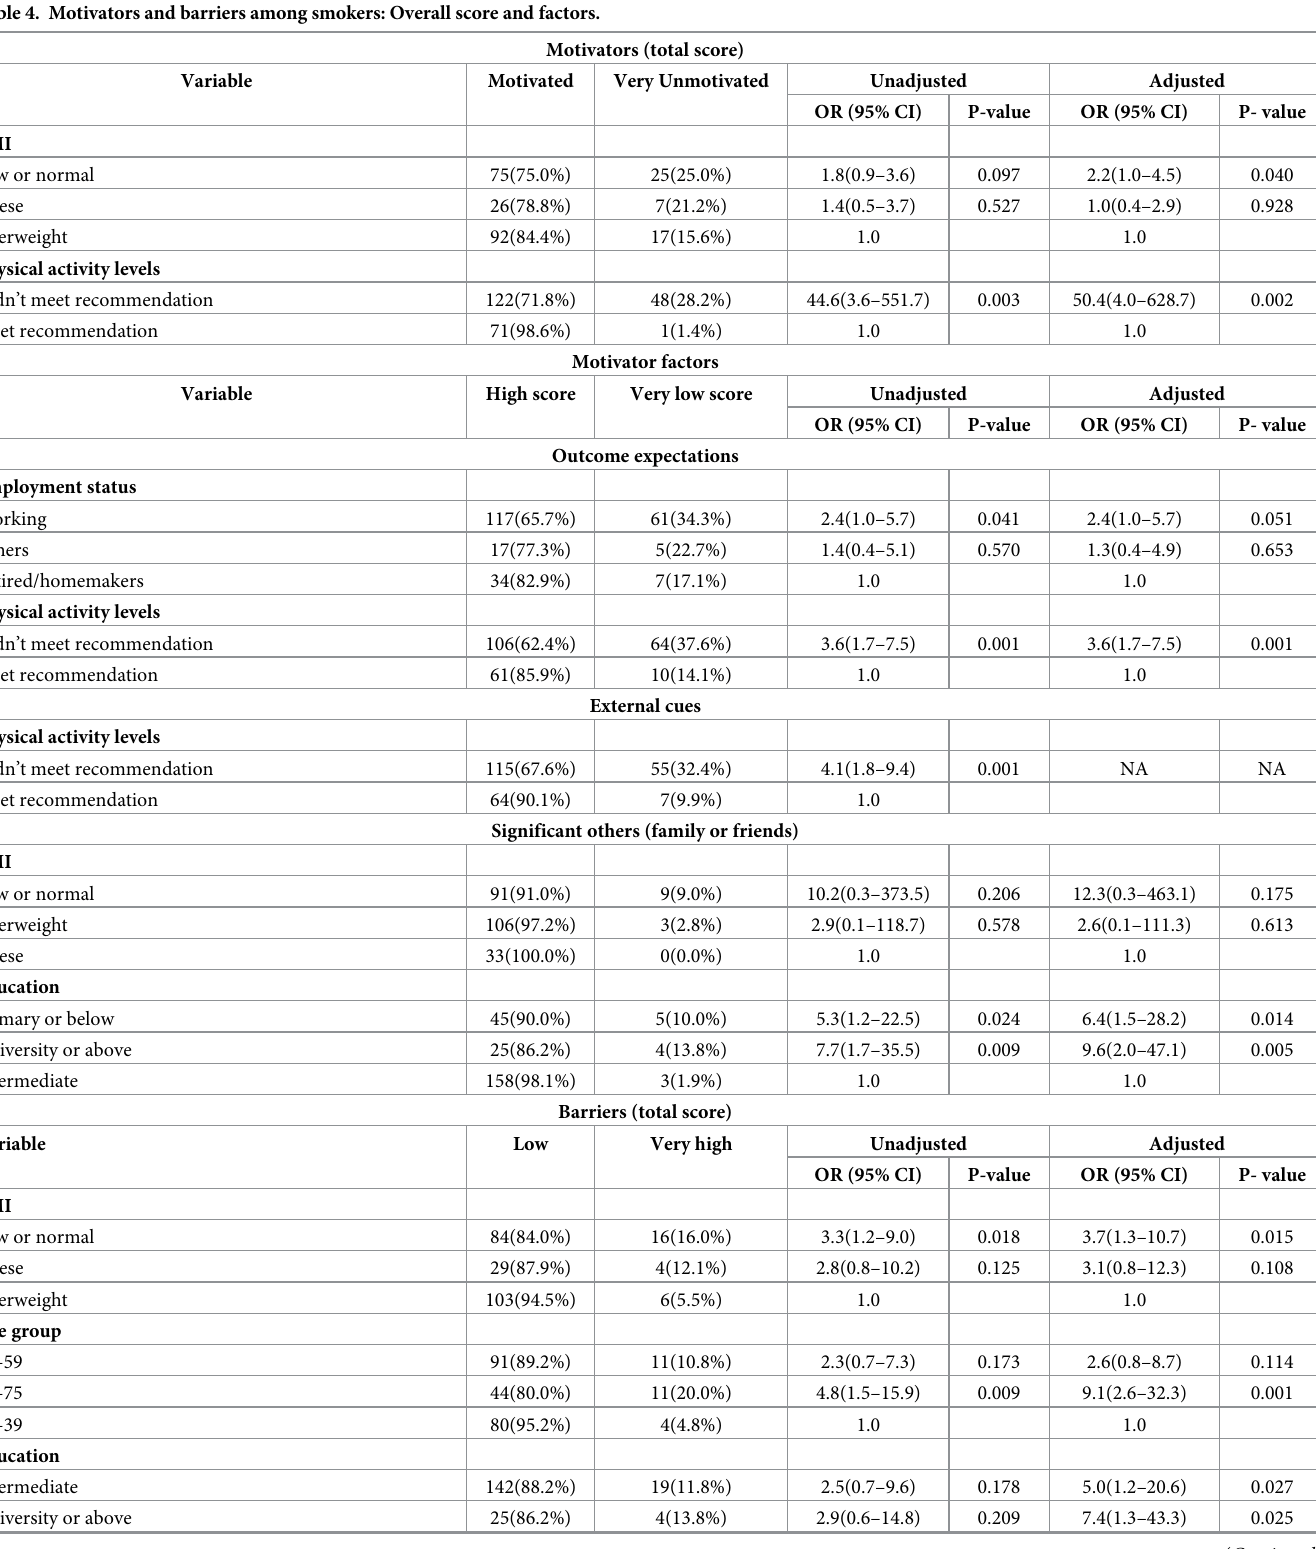
Table 4. Motivators and barriers among smokers: Overall score and